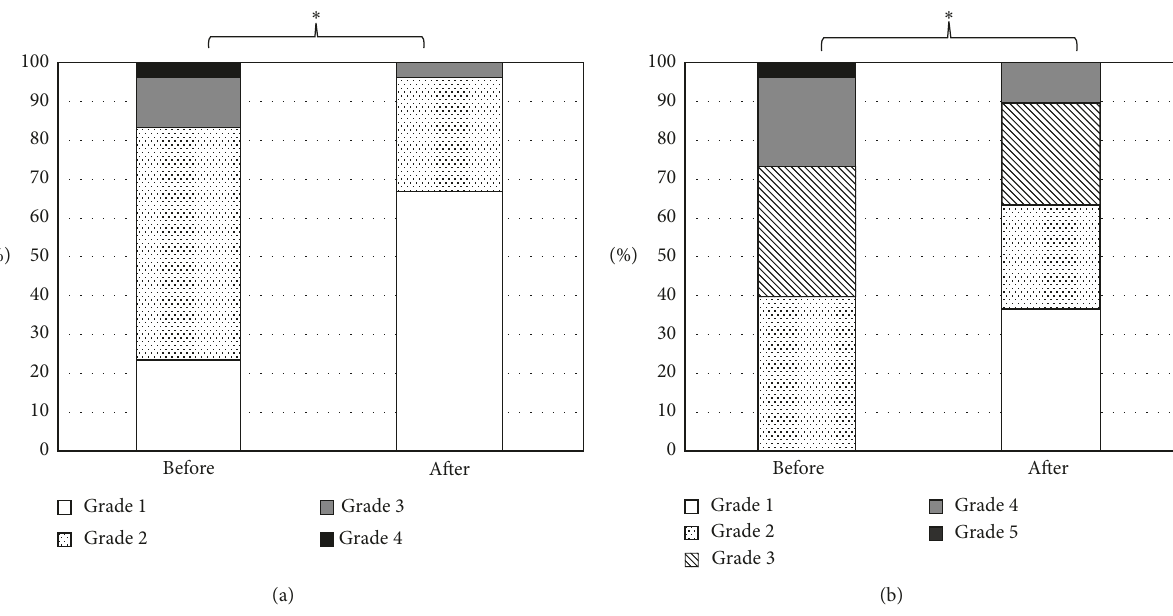
Figure 2: Changes in tear film status. Changes in distribution of tear film spreading grade (a) and tear interferometry grade (b) before and after Trabectome surgery. ∗ P < 0 . 05, contingency table